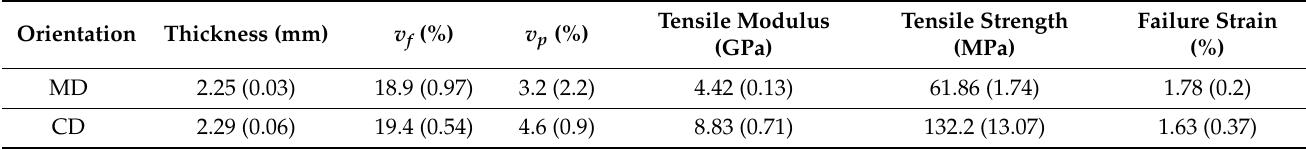
Figure 11. Anisotropy index and ratios characterising parameters between the two main directions (MD and CD) of the nonwoven material.